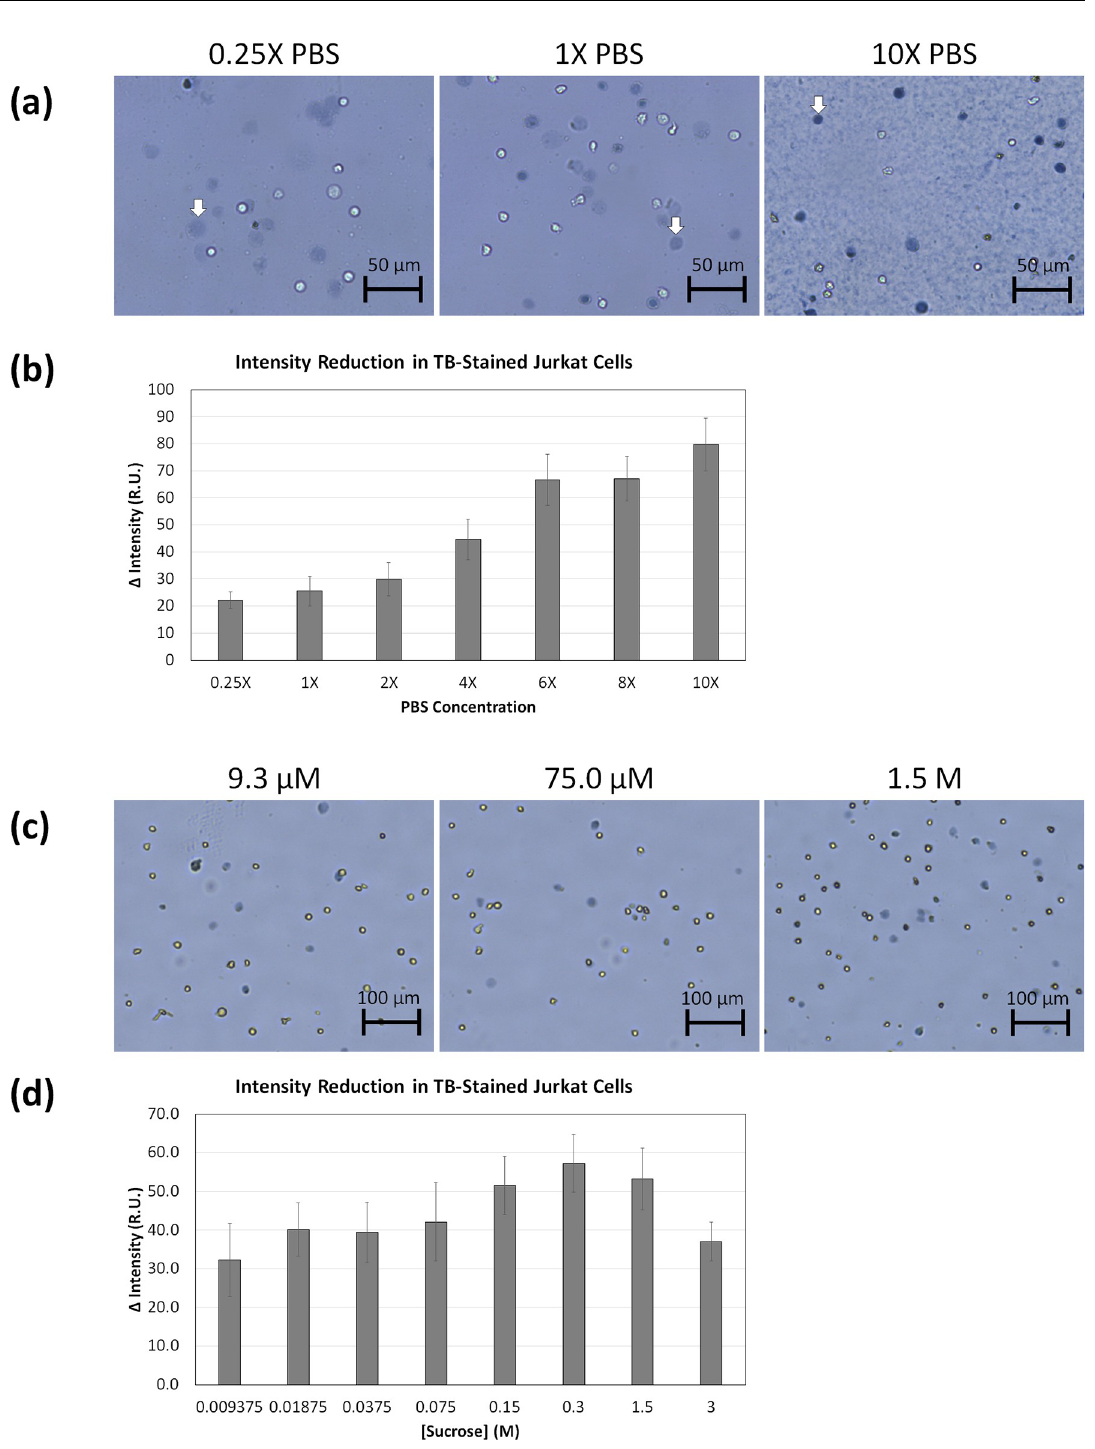
Fig 7. Bright field images and trypan blue intensity analysis of aged Jurkat cells resuspended in different buffer concentrations. (a) Jurkat cells were resuspended in 0.25, 1, 2, 4, 6, 8, or 10X concentrated PBS, and imaged using the AutoM10. The white arrows indicated the change from diffuse to dark objects as PBS concentration increased, (b) which was also validated with ImageJ intensity measurement of the TB-stained cells. A significant precipitation formed when exposed to high salt concentrations with trypan blue. (c) Jurkat cells were resuspended in 9.4, 18.8, 37.5, 75.0, 150.0, 300.0, 1500.0, or 3000 μ M of sucrose, and imaged using the AutoT4. Similarly, the bright field images showed increase in TB darkness as sucrose concentration increased, (d) which again was validated by the ImageJ intensity